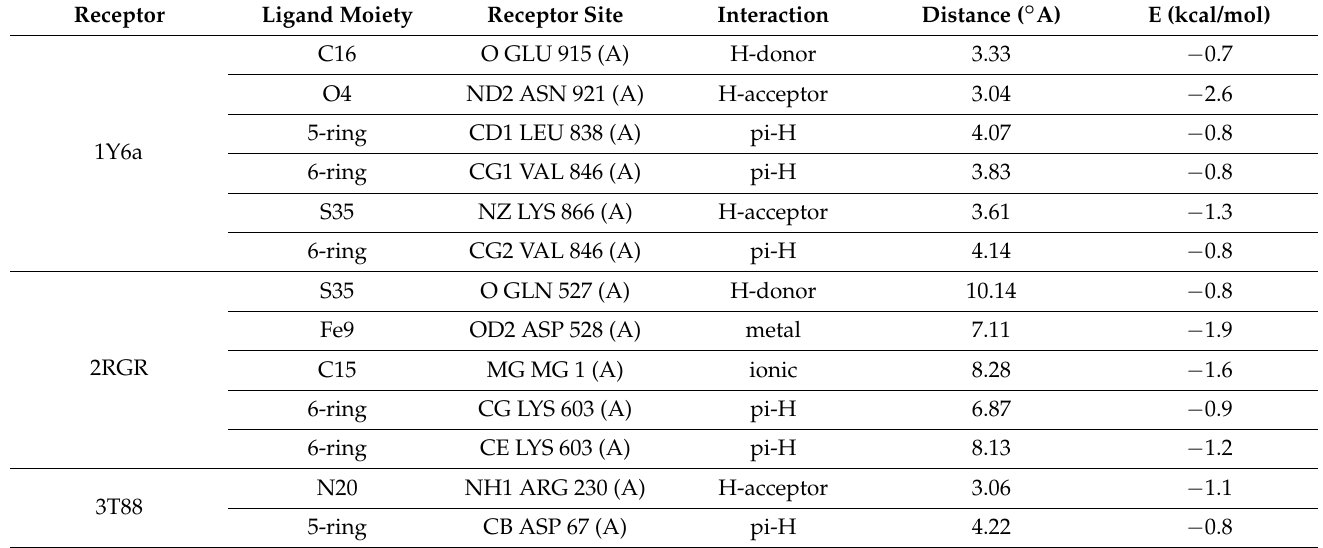
Table 6. Energy values obtained in docking calculations of HL with crystal structure of (1Y6a), the receptors of (2RGR), crystal structure of Escherichia coli (3T88). Receptor